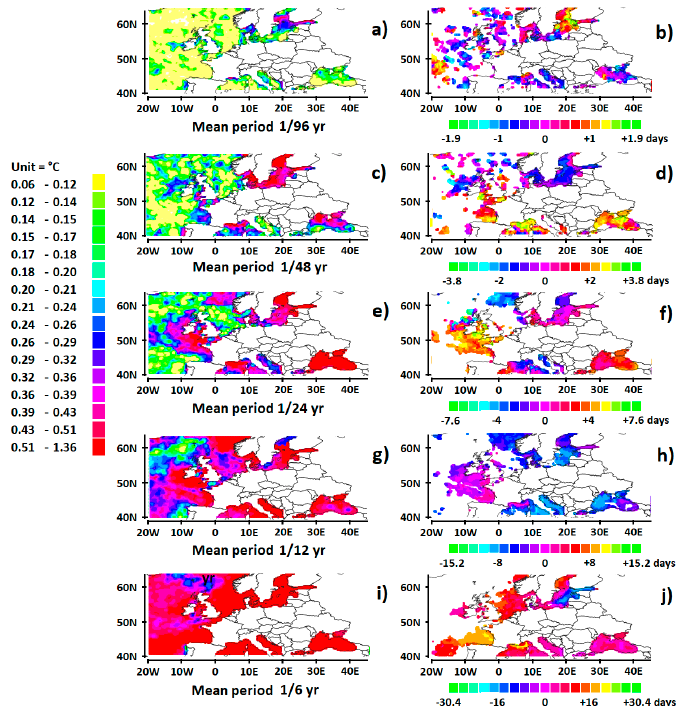
Figure 9. Same as Figure 8 for the amplitude ( a , c , e , g , i ) and the phase ( b , d , f , h , j ) of SST. SST anomalies are positive when the time lag is zero. Same data sources as in previous figures.